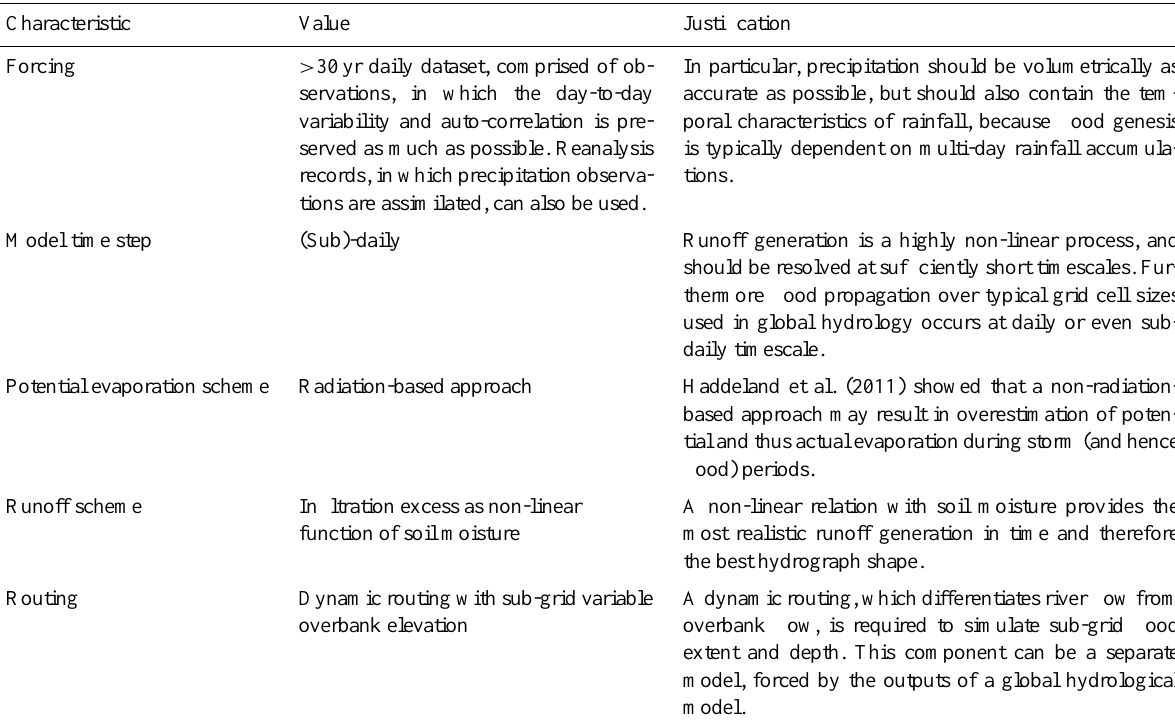
Table 1. Required model